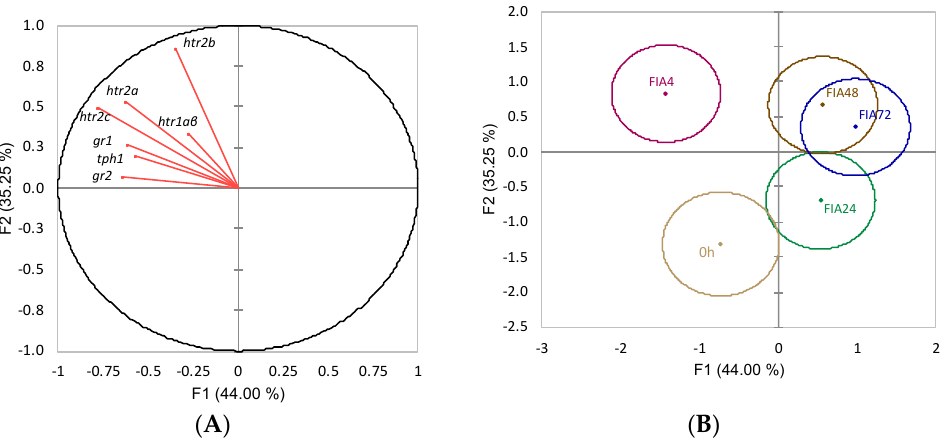
Figure 2. Canonical discriminant analysis of European seabass telencephalic expression of HPI-axis- related genes. ( A ) Correlation variables/factors (factor loads) for two main discriminant functions (F1 and F2); gr1 , glucocorticoid receptor 1; gr2 , glucocorticoid 2; htr1a β , serotonin receptor 1A β ; htr2a , serotonin receptor 2A; htr2b , serotonin receptor 2B; htr2c , serotonin receptor 2C; tph1 , tryptophan hydroxylase 1. ( B ) Canonical discriminant scores of each group. Group centroids are marked by a small diamond, whereas circles indicate data distribution per group.